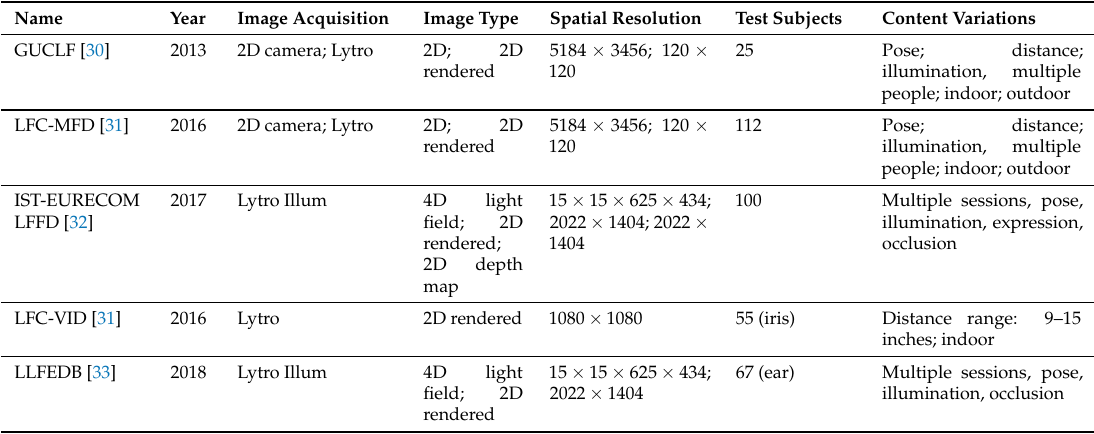
Table 2. Light-field face (and facial component)